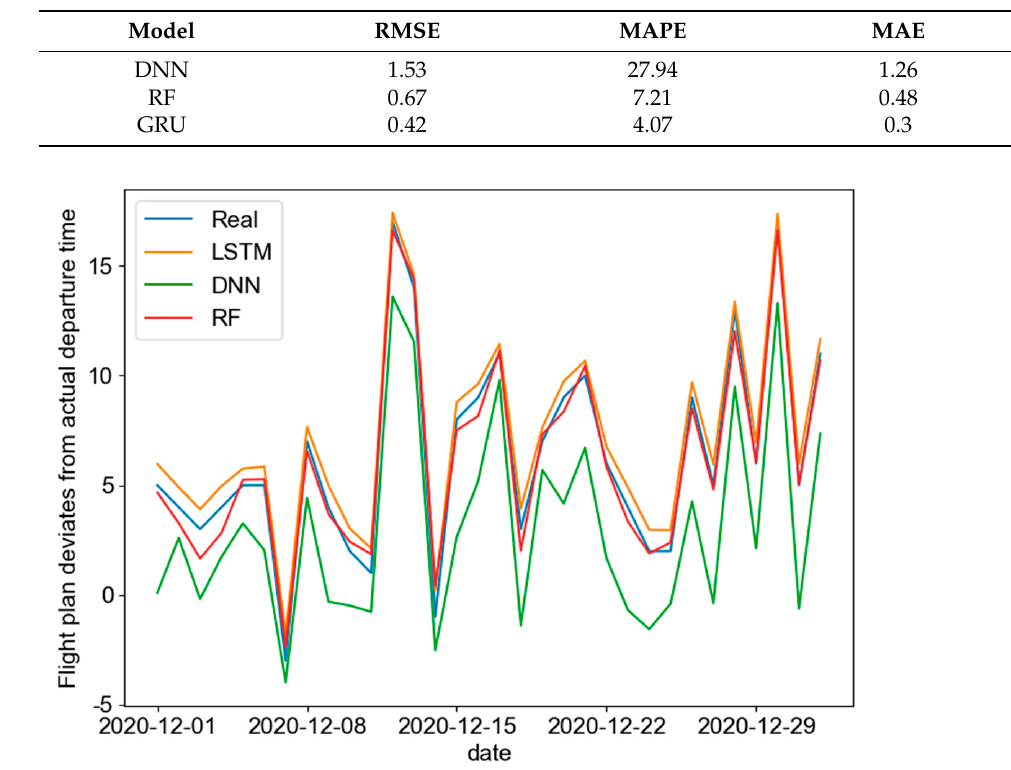
Table 7. Comparing the results with the delay prediction model.